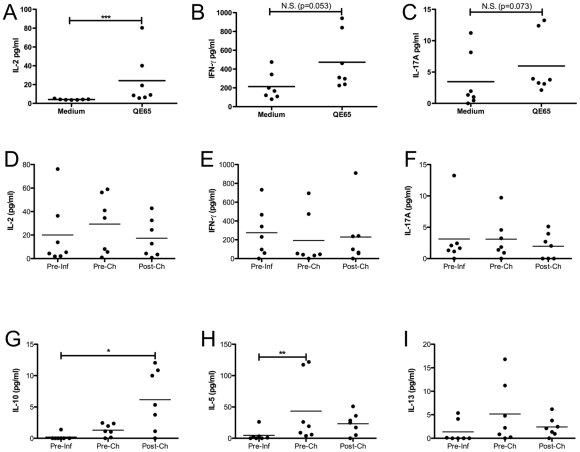
Duodenal biopsies were taken from trial 2 participants pre-infection (Pre-Inf, week 0), pre-challenge (Pre-Ch, week 20) and post-challenge (Post-Ch, week 21) and cultured in either medium alone or with 50 µg/ml QE65 peptide for 24 hours at 37°C in 95% O2/5% CO2.Supernatants were then taken and levels of cytokines measured by CBA. Results shown in A–C are from the pre-infection timepoint only, showing both medium and QE65 levels. All other results (D–I) have had medium controls subtracted. Cytokines shown are IL-2 (A, D), IFN-γ (B, E), IL-17A (C, F), IL-10 (G), IL-5 (H) and IL-13 (I). A–C was analysed by paired t tests, D–I by 1-way ANOVA. Where data was not normally distributed, log-transformation was carried out and parametric tests used. Differences are not significant unless indicated. * = p<0.05, ** = p<0.01.